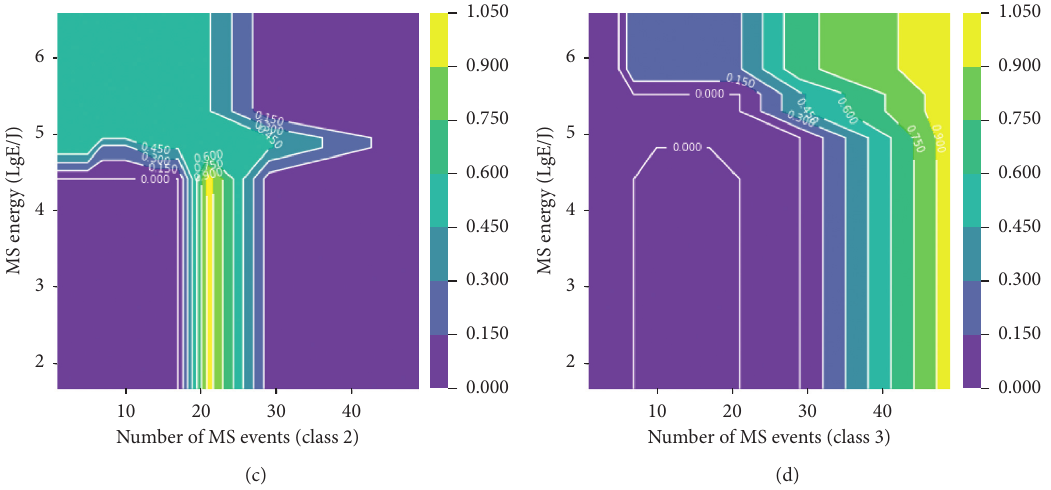
Figure 10: Interactive impact of the energy and events’ number of MS on rockburst.